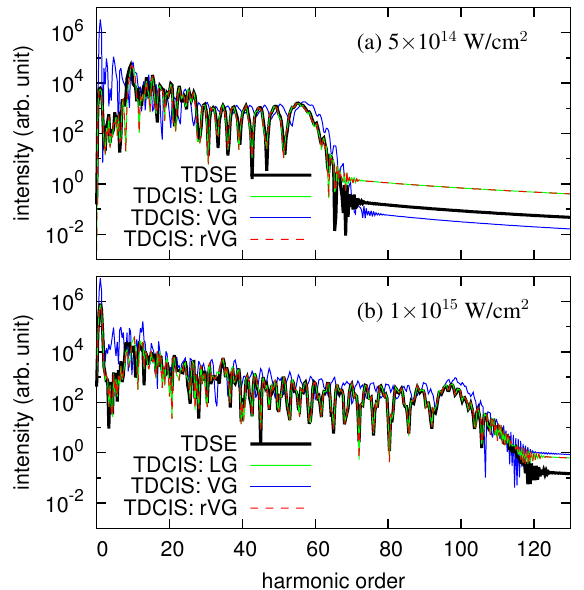
Figure 4. High-harmonic spectrum of 1D-He exposed to a laser pulse with a wavelength of 750 nm and an intensity of ( a ) 5 × 10 14 W/cm 2 and ( b ) 1 × 10 15 W/cm 2 . Comparison of the results with TDCIS in the LG, VG, and rVG with that of